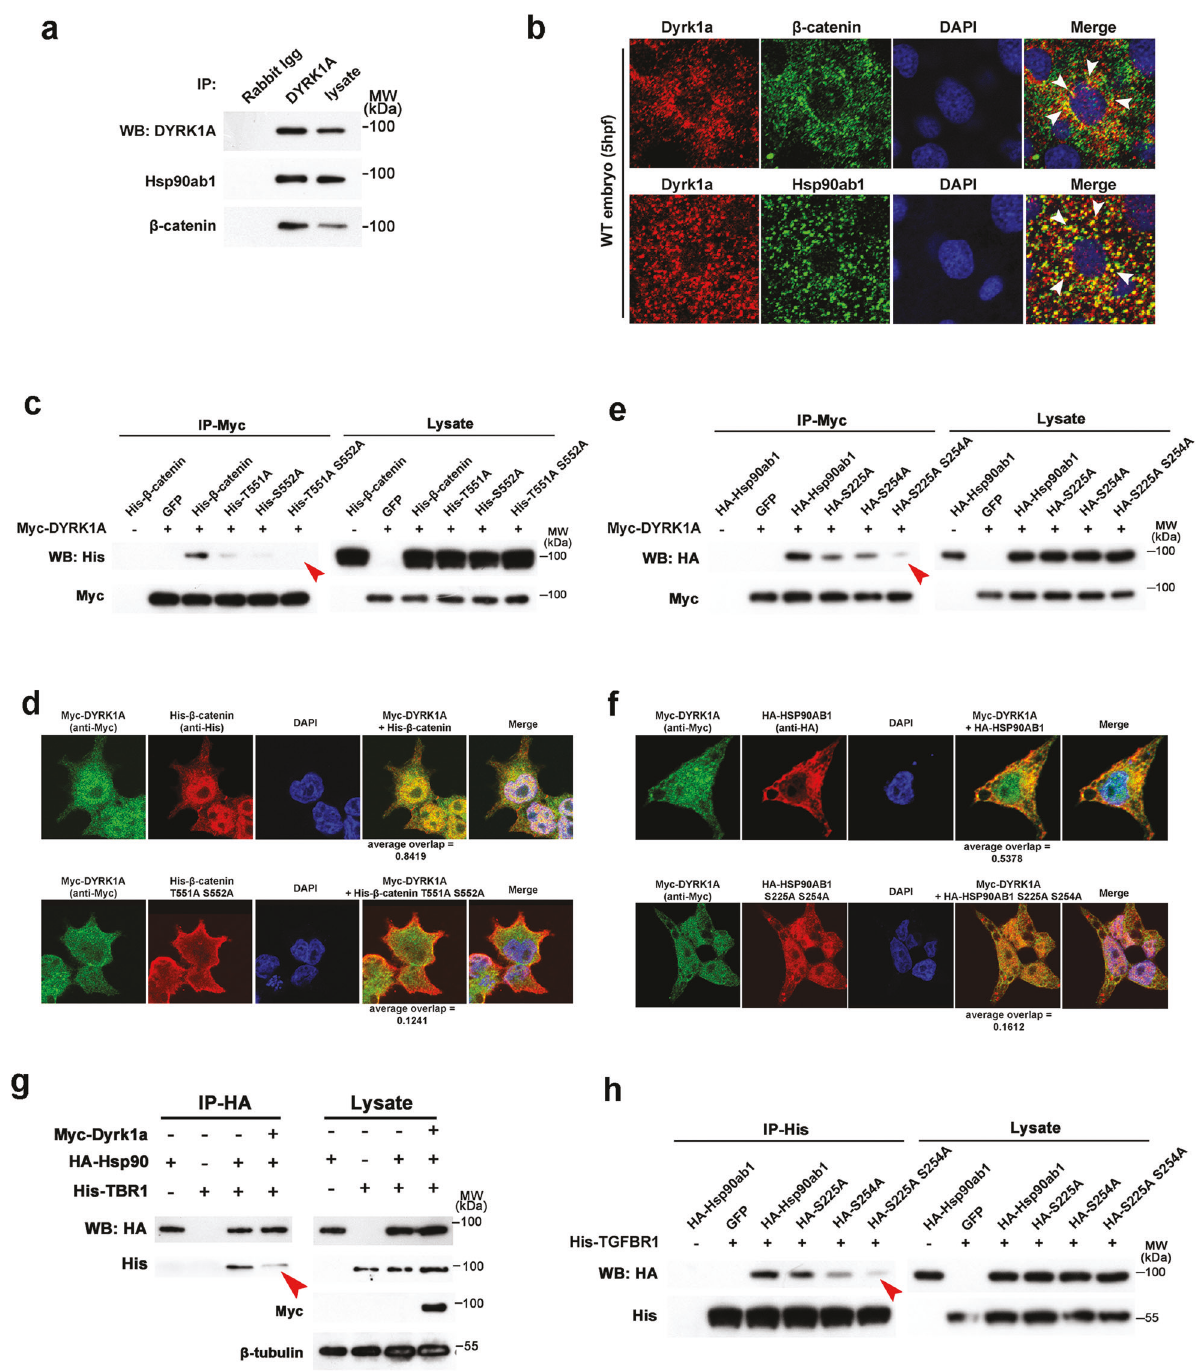
Fig. 3 Phosphorylation sites of β -catenin and Hsp90ab1 are required for its interaction with DYRK1A and signaling transduction. a Co- immunoprecipitation (Co-IP) of endogenous DYRK1A and β -catenin/Hsp90ab1 in zebra fi sh embryos. b Co-localization of DYRK1A and β -catenin/Hsp90ab1 in the zebra fi sh embryo. Arrowheads indicate colocalized sites. c Co-IP shows the interaction of DYRK1A with β -catenin is abolished by T551A and S552A mutation. d Immuno fl uorescence analysis in HEK293 cells shows the reduced localization of β -catenin T551A and S552A mutant with DYRK1A. e Co-IP shows the interaction of DYRK1A with Hsp90ab1 is impaired by S225A and S254A mutation. f Immuno fl uorescence analysis in HEK293 cells shows that Hsp90ab1 S225A and S254A mutant is less co-localized with DYRK1A. g Co-IP/ western blot analysis in HEK293 cells shows that DYRK1A overexpression decreases the protein – protein interaction between Hsp90ab1 and TGF- β receptor. h Hsp90ab1 S225 and S254 sites are required for its interaction with the TGF- β receptor. Red arrowheads in ( c , e , g , h ) indicate the decreased interaction of